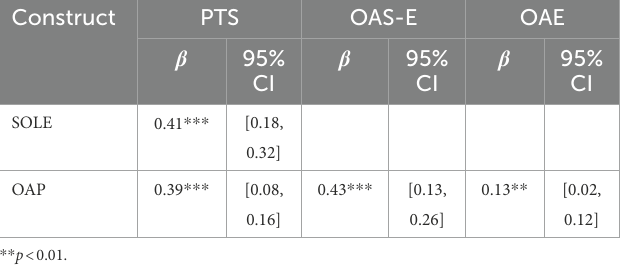
TABLE 5 Indirect effect analysis.